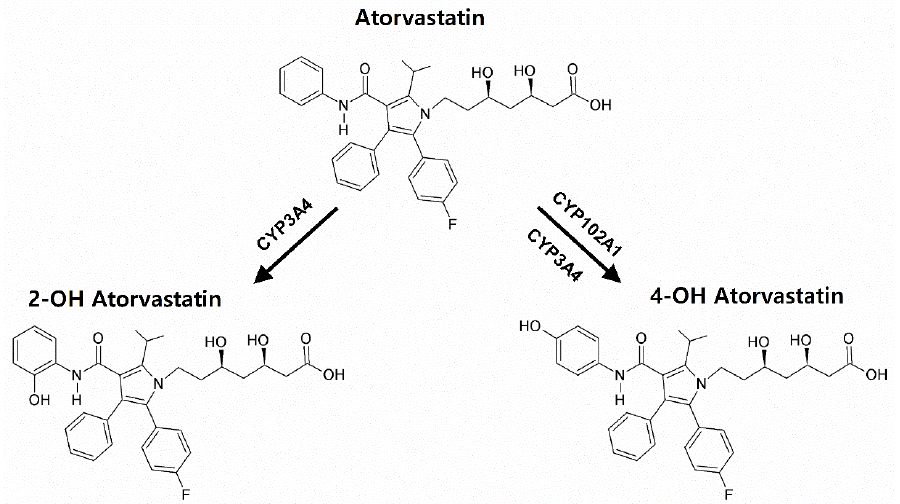
Figure 1. Chemical structures of atorvastatin and its metabolites, 2-OH and 4-OH atorvastatin. The metabolites are made in the human liver by CYP3A4. Bacterial CYP102A1 mutants can make only one metabolite, 4-OH atorvastatin.